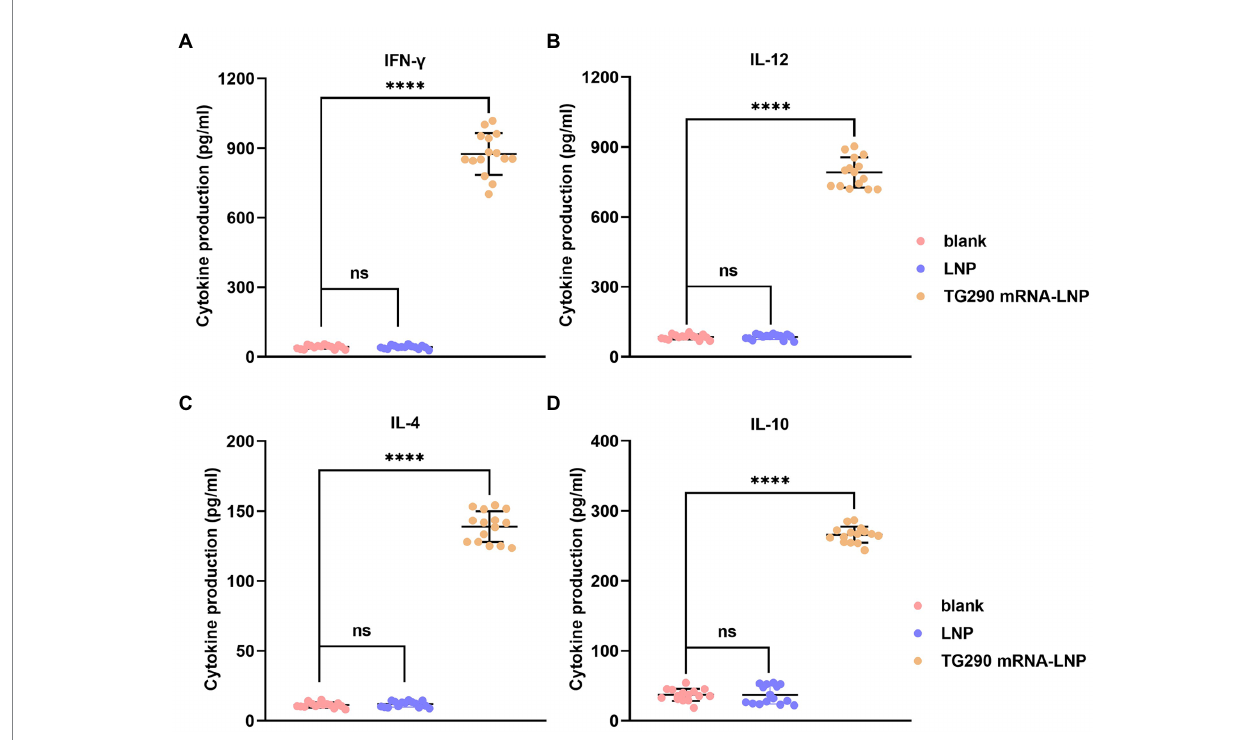
FIGURE 4 The determination of cytokines. The prepared spleen cell suspension was obtained from mice 2 weeks of the last vaccination. The levels of (A) IFN- γ and (B) IL-12 and (C) IL-4 and (D) IL-10 in BALB/c mice immunized with TG290 mRNA-LNP vaccine. Data were obtained from triplicate independent experiments and are presented as means ± SD ( n = 5). **** p < 0.0001, analyzed by one-way ANOVA multiple comparisons (compare the mean of each group with the mean of every other group).